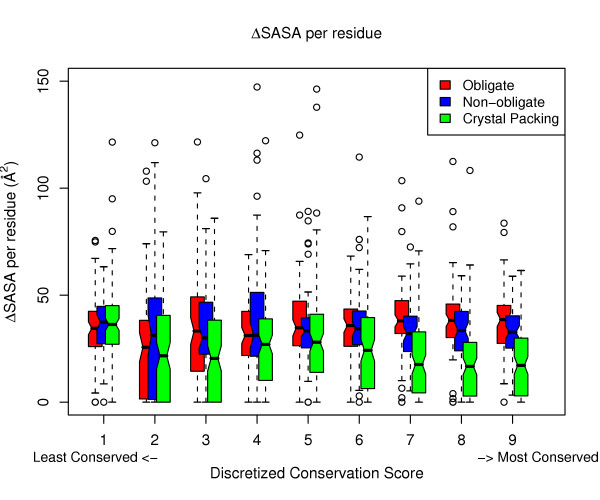
Average ΔSASA per residue for different degrees of conservation. Conservation scores from ConSurf are discretized using the same coloring scheme as that used in [48]. The larger the discretized ConSurf scores, the more conserved the residues in evolution. The conserved residues tend to be more strongly involved in the biological interfaces.